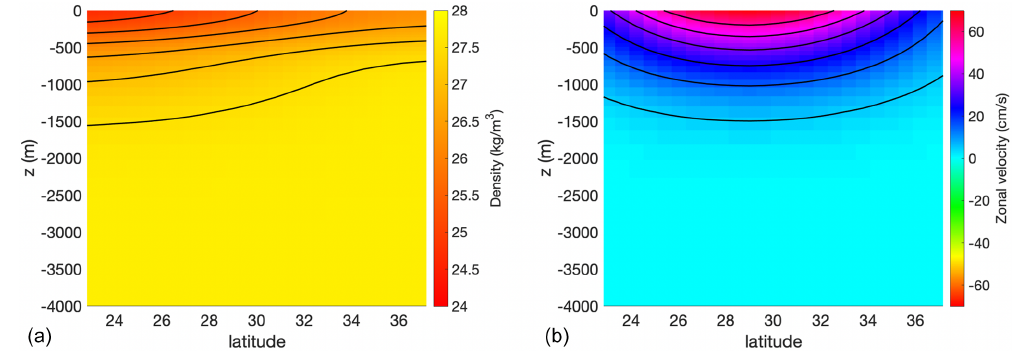
Figure 7. The initial geostrophically balanced density and zonal velocity profiles for the baroclinic jet case. (a) Initial density anomaly ρ − 1000kgm − 3 . Contours at levels 25, 25.5, 26, 26.5, 27, 27.5kgm − 3 . (b) Zonal velocity. Contours at levels 5, 15, 25, 35, 45, 55cms − 1 .